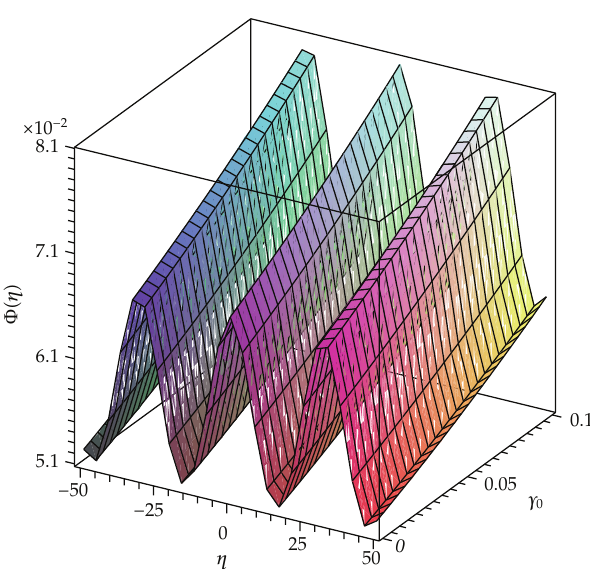
Figure 4: The asymptotical property of Jacobi elliptic doubly periodic wave for expression (cid:2) 4.10 (cid:3) with v (cid:7) 0 . 04, σ (cid:7) 0 . 001, a 0 (cid:7) 0, and m (cid:7) 2.